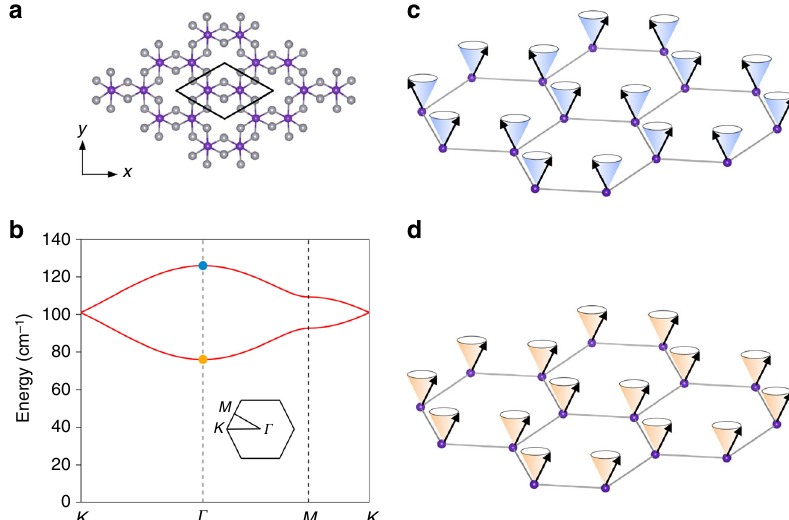
Fig. 1 Magnetic excitations in the 2D Ising ferromagnet CrI 3 . a Top view of the atomic structure of monolayer CrI 3 , with Cr 3 + in purple and I – in gray. Cr 3 + ions form a honeycomb lattice with two Cr 3 + ions per unit cell (black enclosure). b Calculated magnon dispersion relation in monolayer CrI 3 . The inset shows the Brillouin zone. Magnon modes at the zone center ( Γ point, zero-momentum) are highlighted by yellow and blue solid circles. c , d Schematic of the zone center magnon modes. The cones represent the precession trajectories of the spins (black arrows). The precession of spins on two Cr 3 + sublattices are out-of-phase ( c ) and in-phase ( d ), which corresponds to the high- and low-energy modes, respectively, in